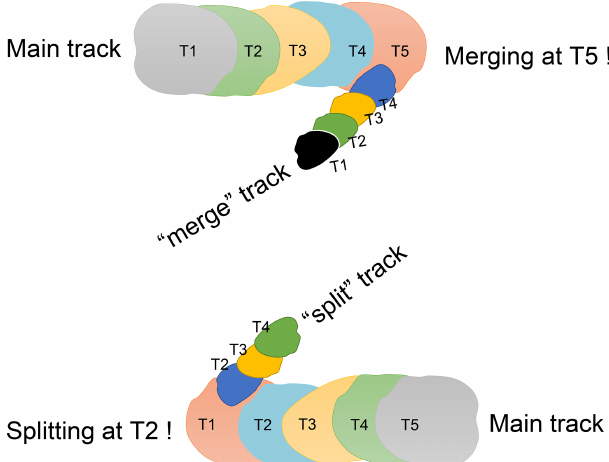
Figure A3. Schematic of “merge” tracks and “split” tracks.